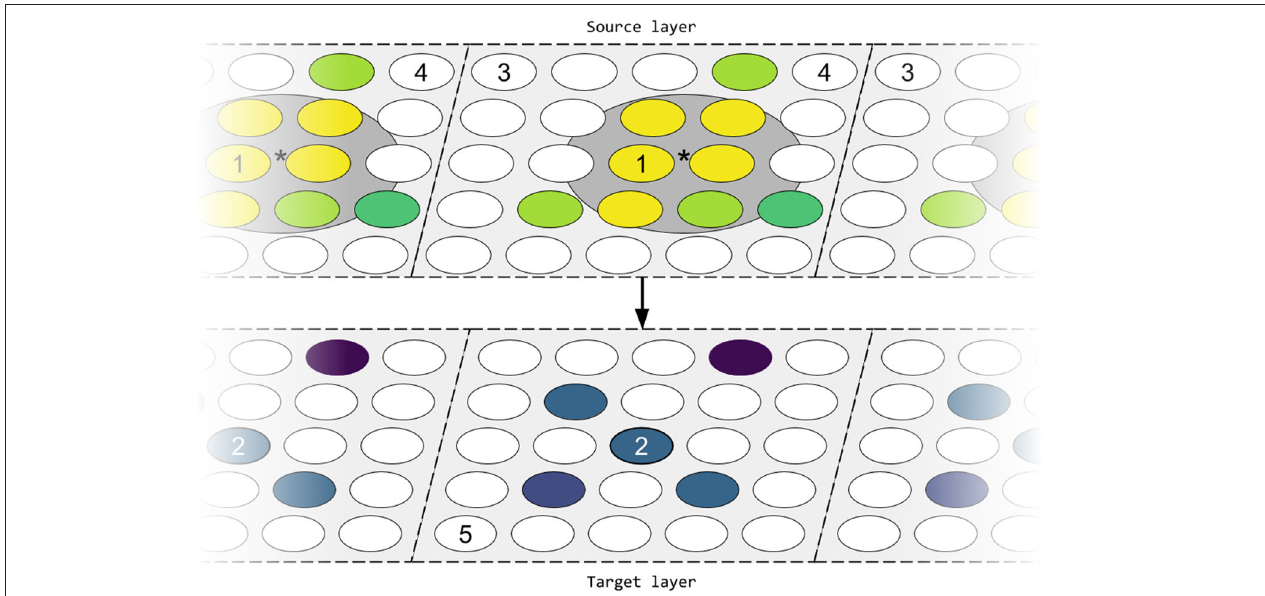
FIGURE 1 | Simplified network architecture. Neurons are placed on a rectangular mesh at discrete locations. Neuron 2 in the target layer has a receptive field formed by the connections from the source layer (feedforward), as well as connections coming from within the target layer (lateral). These connections will ideally be centred around the spatially closest neuron (the ideal location), i.e., neuron 1 in the case of feedforward connections, or around itself for lateral connections. In practice, a limited number of synapses means that the center of the receptive field (*, computed as the location which minimizes the weighted variance of the feedforward connections) will deviate from the ideal location. Additionally, connections from more distant neurons are likely to decrease in strength (darker color equates with weaker connections); cells in white do not connect to neuron 2. The topology of the network is toroidal; periodic boundary conditions are denoted by dashed edges and the layer tessellation. Here, the distance between neurons 3 and 4 in source layer is equal to the distance between neurons 3 and 5 in the source and target layer respectively (1